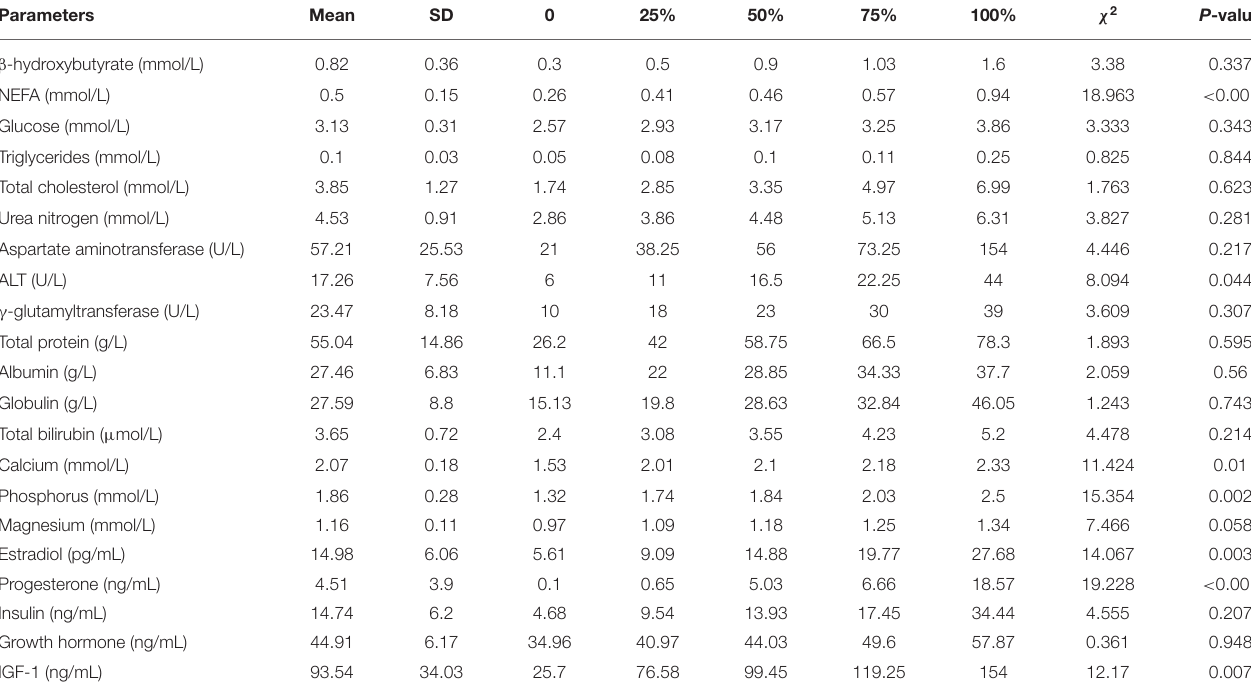
TABLE 2 | Kruskal-Wallis test of plasma energy metabolites, liver function indicators, minerals and hormones among the four groups ( n = 76). Parameters